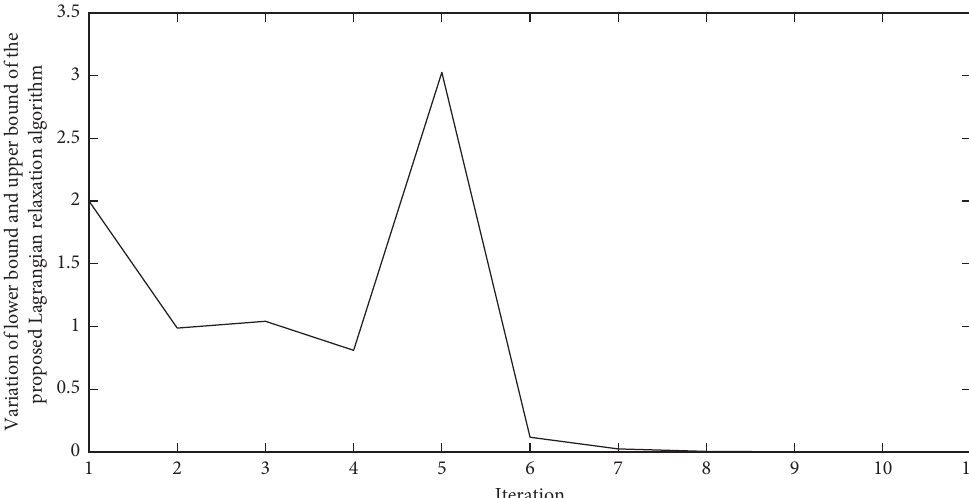
Figure 7: Variations of lower bound and upper bound. In this figure, the ordinate represents the ratio of the gap between lower and upper bound to lower bound. Through the iterating process, the algorithm was stopped when this ratio was less than